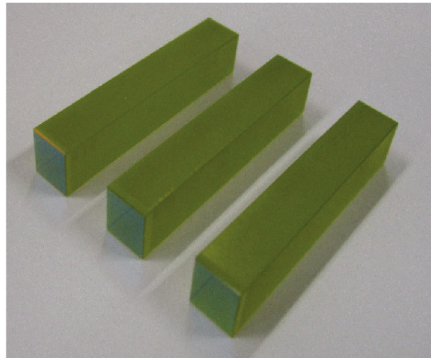
Figure 3: Rod-type Ce/Cr/Nd:YAG ceramic.